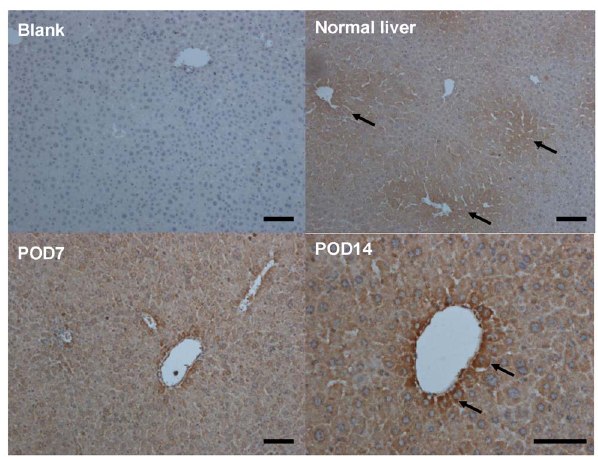
Figure 2. Parenchymal localization of NGF peptide in hepato- cytes with cholestatic injury. The mice receiving bile duct ligation surgery were sacrificed at POD7 and POD14 and the liver tissues were fixed with formalin. Paraffin-embedded tissue sections were subjected to immunohistochemisty NGF staining. Arrows indicate the parenchy- mal localization of NGF antigenicity in zone 3. Bars, 50 m m.